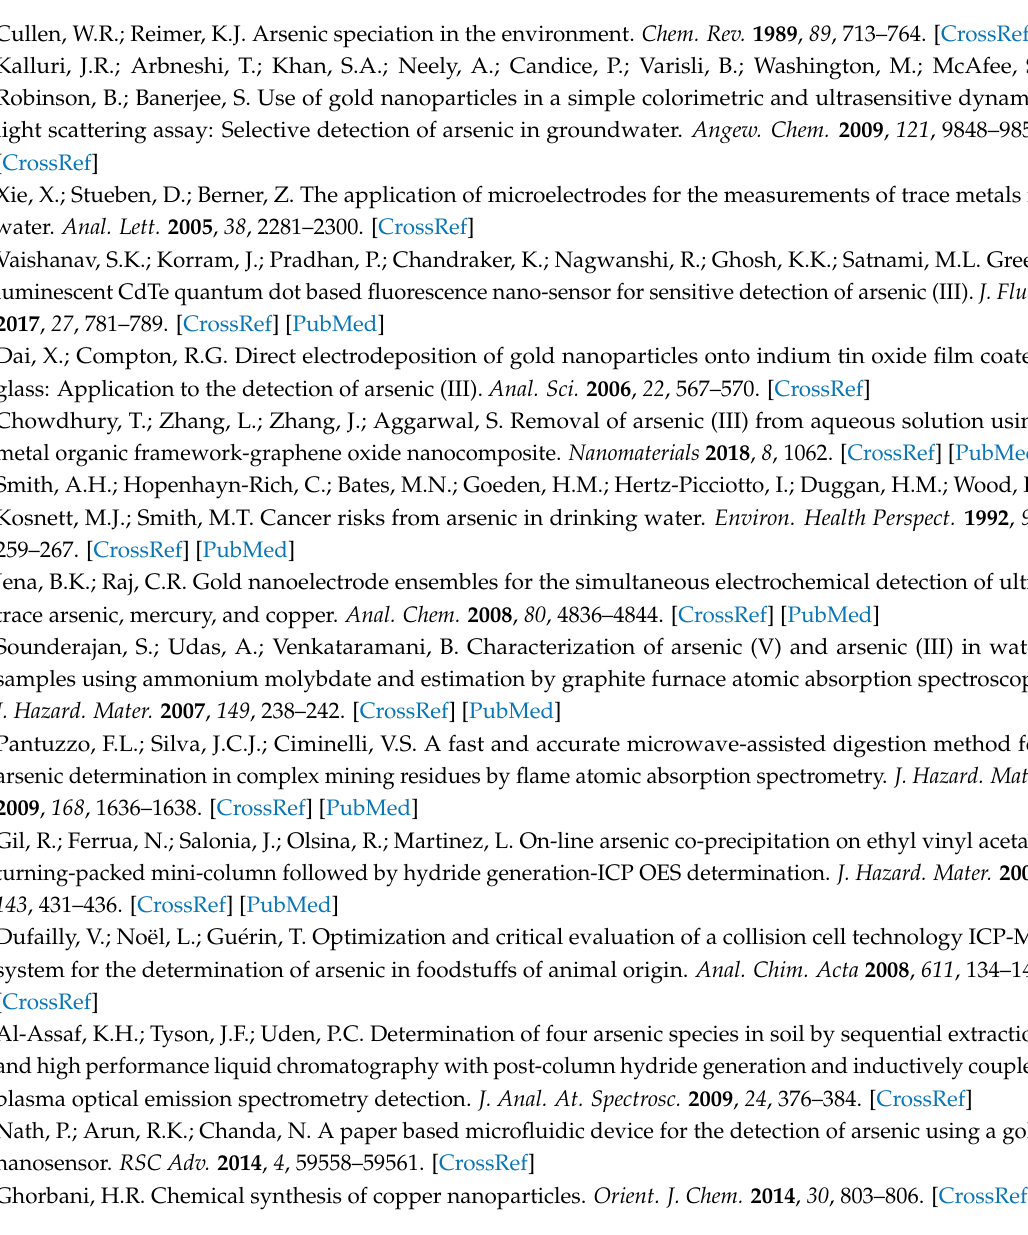
Figure S1: Optimization studies for formation of Rano-Cu NPs, Figure S2: FTIR spectra of pure ranolazine and ranolazine-functionalized Cu NPs, Figure S3: XRD patterns of Rano-Cu